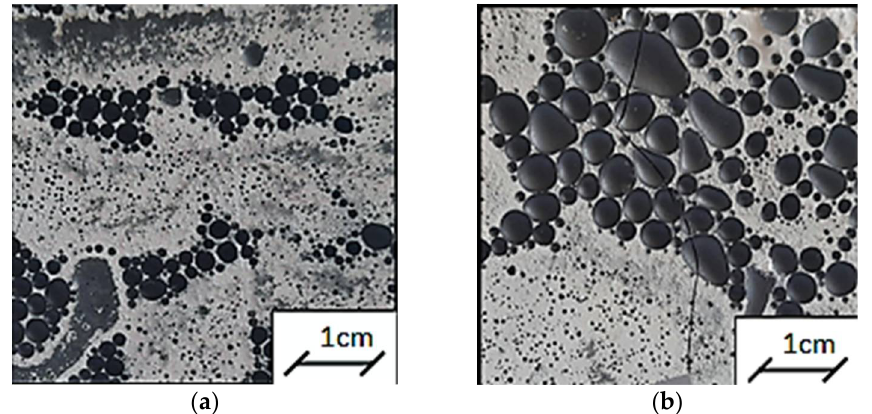
Figure 1. Reference samples used in the thermal tests after 28 days of conditioning under hygrothermal conditions: ( a ) RSS1, ( b ) RSF1.